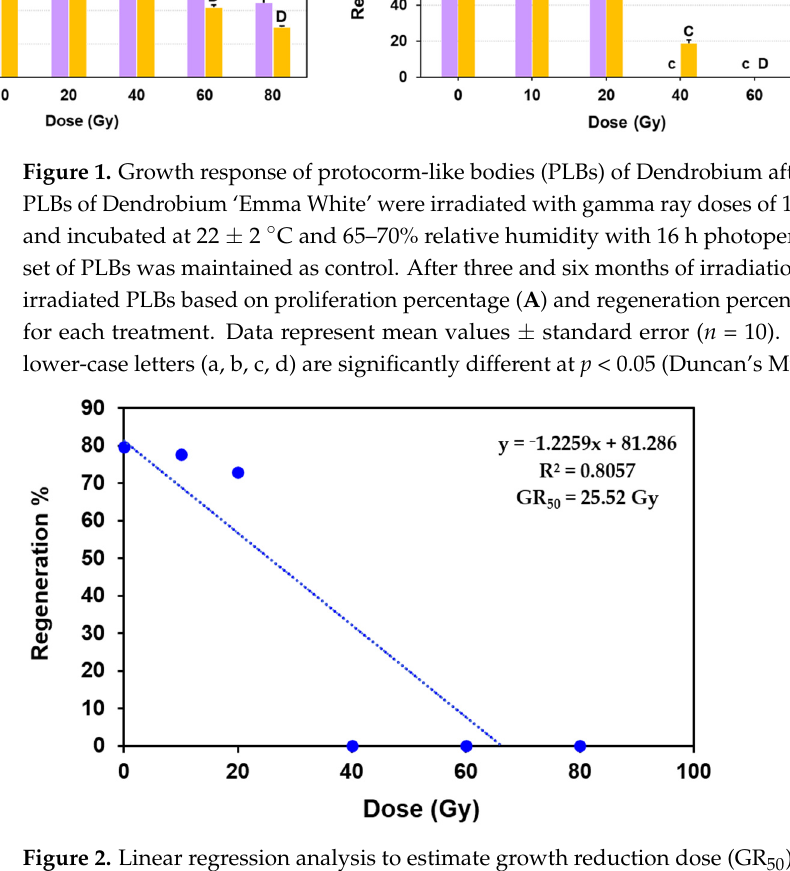
Figure 2. Linear regression analysis to estimate growth reduction dose (GR 50 ) of gamma-irradiated protocorm-like bodies of Dendrobium ‘Emma White’. Shoot regeneration response of PLBs irradi- ated with gamma rays of 10, 20, 40, 60 and 80 Gy after three months of radiation treatment was used to estimate GR 50 . The mean values of regeneration percentage were analyzed using linear regression equation (y = mx +